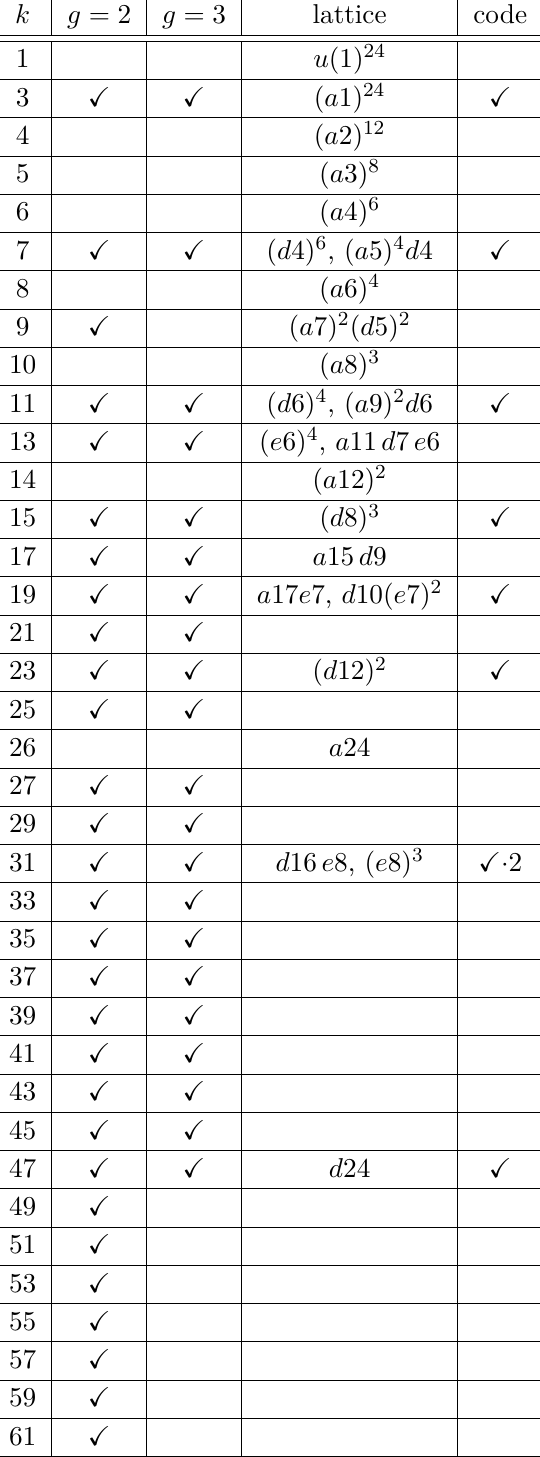
Table 4. Polynomials organized by number of spin 1 currents N currents = 24 k . The number of currents may be computed from the genus 1 polynomial using N the list of lattices organized by the number of